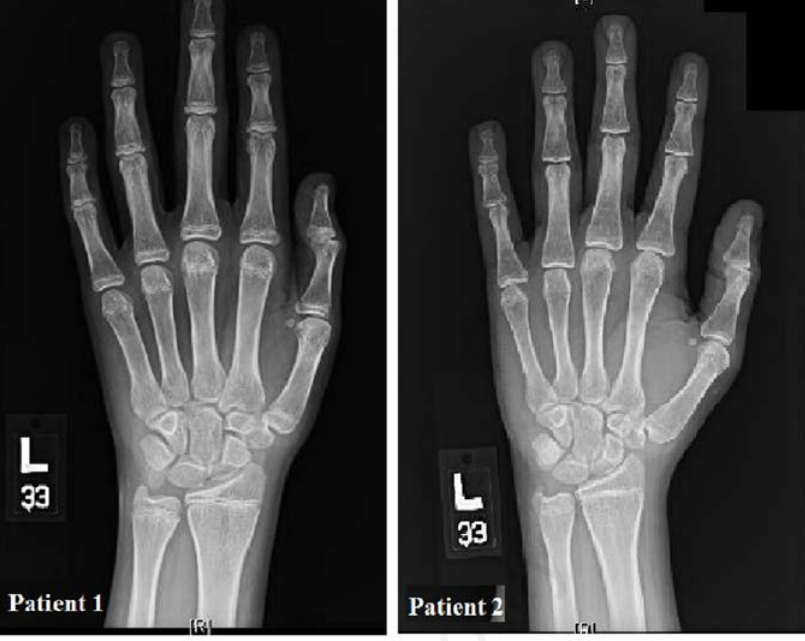
Figure 2. Hand X-ray showed delayed bone growth. Patient 1: The chronological age of this patient is 20 years. The metacarpal heads and growth plates of the phalanges are not fused yet. The carpal bones are well ossified. The bone age of this patient is about 14 years to 15 years. Patient 2: The chronological age for the patient is 25 years. The growth plate of the distal radius and ulna are not fused yet where it normally starts at the age of 17 to 19 and maximally should be fused by the age of 20.